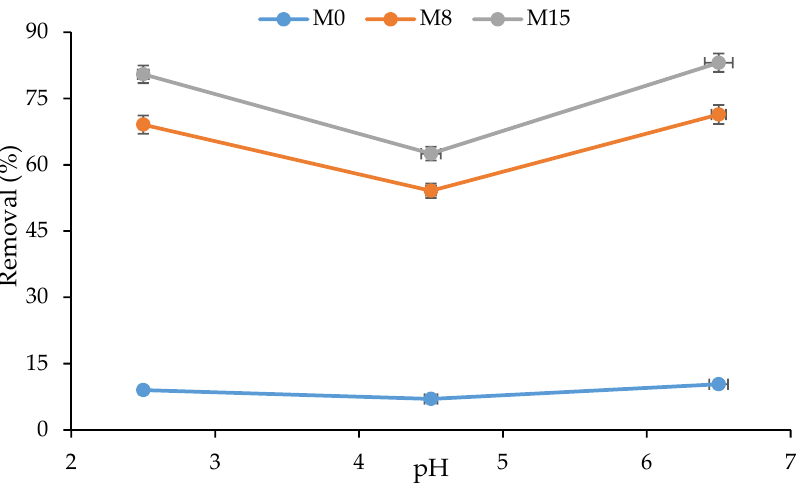
Figure 10. Effect of pH variation on percentage removal of cadmium for the prepared membranes.